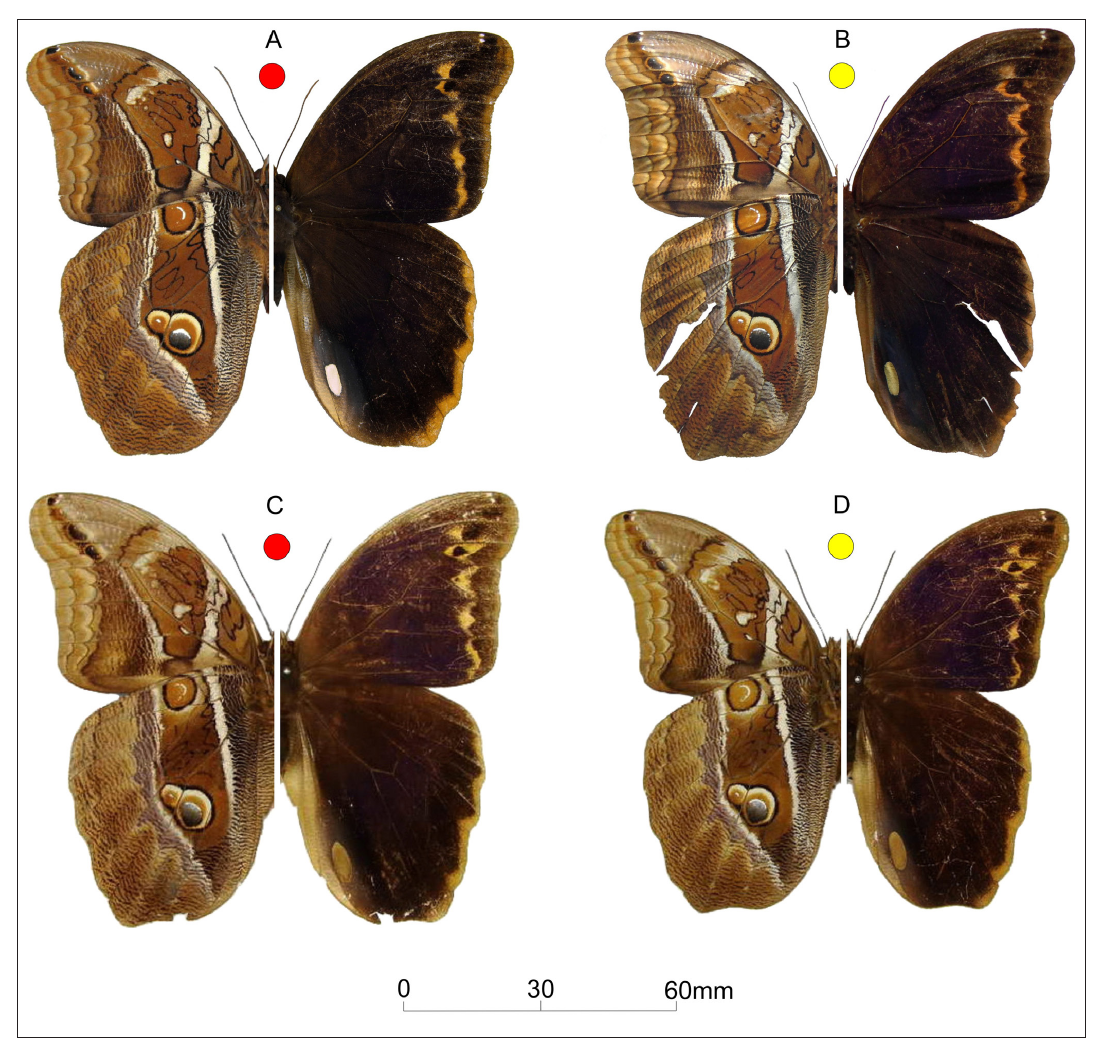
Fig. 6. Habitus of males. Red spot: holotype (HT). Yellow spot: paratype (PT). A . Eryphanis zolvizora reyi ssp. nov., HT (La Chimenea, Barinas, Venezuela; MIZA). B . E. z. reyi ssp. nov., PT (Charalá, Colombia; MNHN, PBB 2321). C . Eryphanis zolvizora isabelae ssp. nov., HT (Choroní, Aragua, Venezuela; R, to be donated to MIZA). D . E. z. isabelae ssp. nov., PT; specimen with reduced forewing spots (Choroní, Aragua, Venezuela;